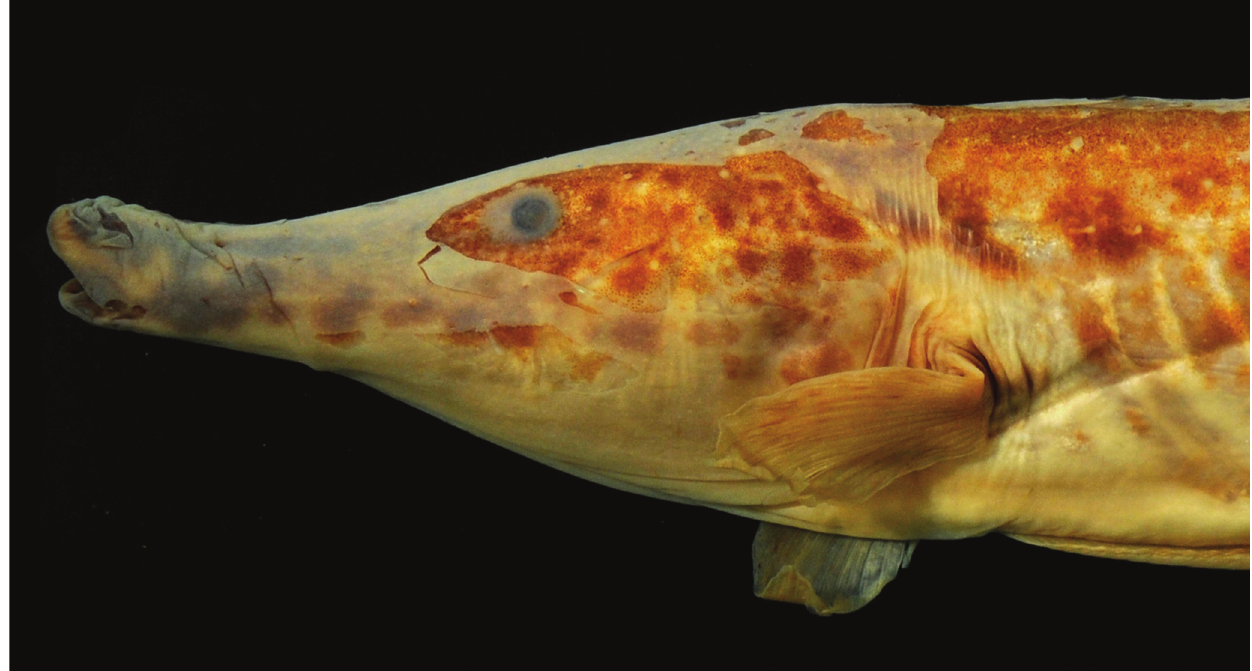
Fig. 2. Head of Iracema caiana , MZUSP 49205 (paratype), 345 mm SL.